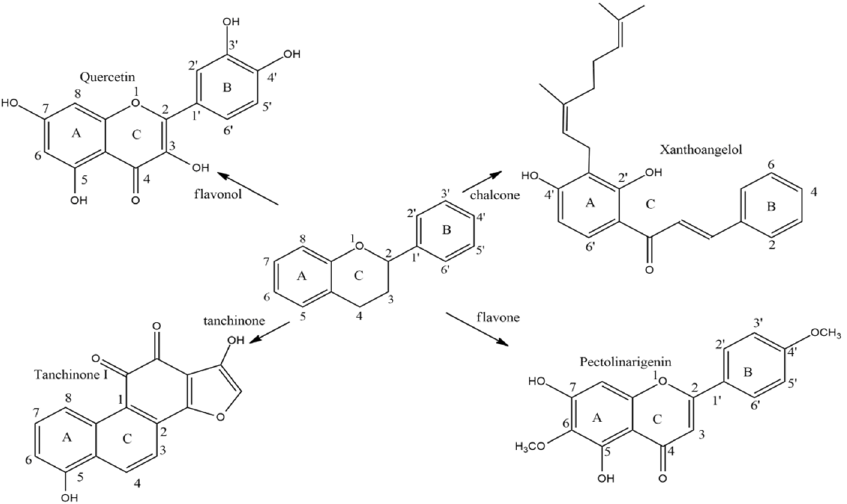
Figure 1. Basic flavonoid structures.